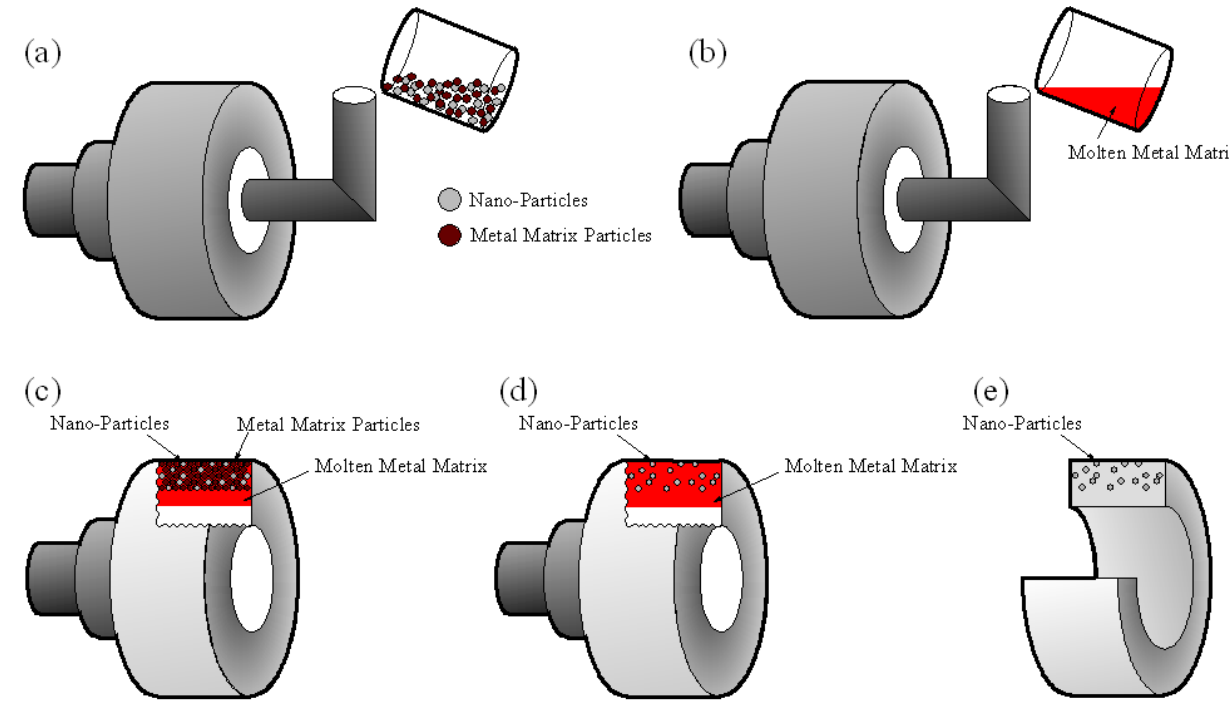
Figure 3. The schematic illustration showing the process of the centrifugal mixed-powder